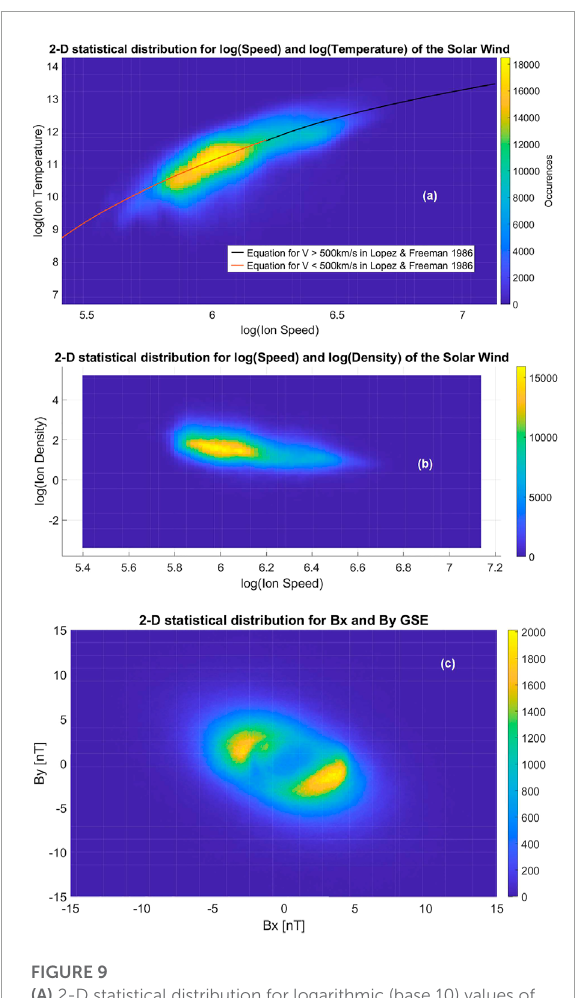
FIGURE 9 (A) 2-D statistical distribution for logarithmic (base 10) values of solar wind speed and logarithmic (base 10) values of solar wind temperature. The two curves (respct. red and black) are the empirical equations from Lopez and Freeman (1986) (respectively for a solar wind speed smaller and greater than 500 km s −1 ). (B) 2-D statistical distribution for logarithmic (base 10) values of solar wind speed and logarithmic (base 10) values of solar wind density. (C) 2-D statistical distribution for the X and Y-components of the IMF [nT] from MAG